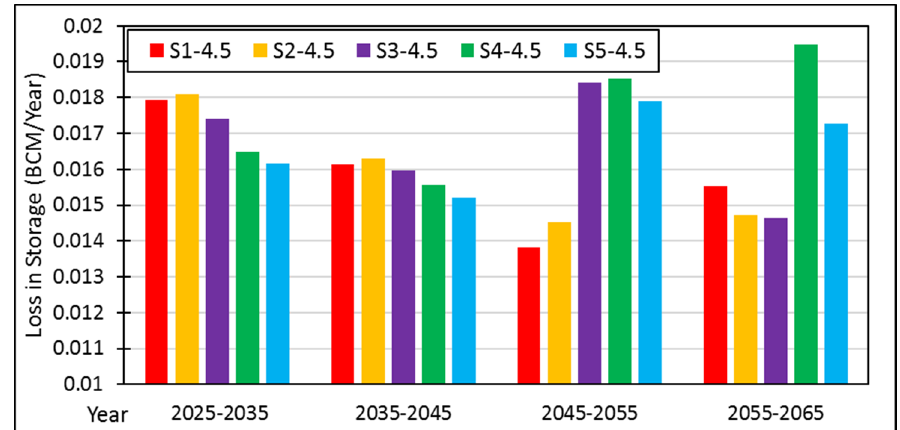
Figure 16. Storage loss due to sedimentation in the main Mangla pocket. Water 2020 , 12 , x FOR PEER REVIEW